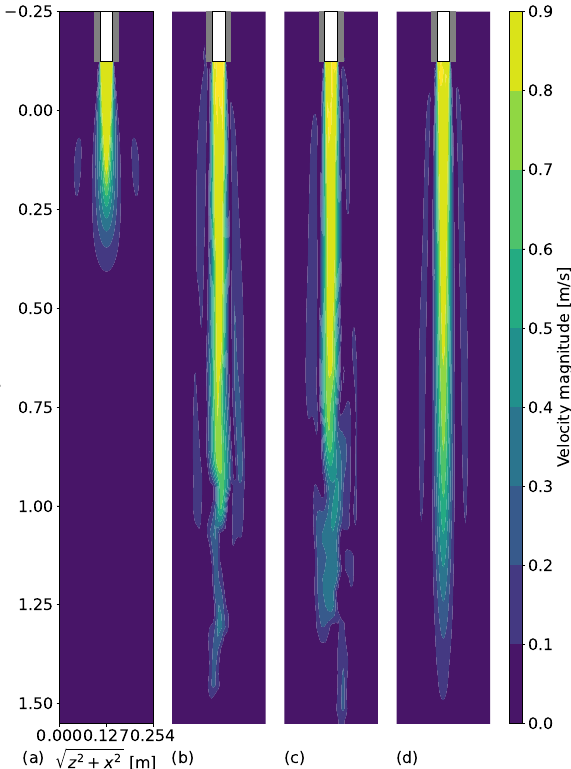
Figure 14. Velocity magnitude field at VA3. ( a ) k − ε model; steady-state; ( b ) LES model at t 1 = 205 s; ( c ) LES model at t 2 = 1096 s; ( d ) LES model;